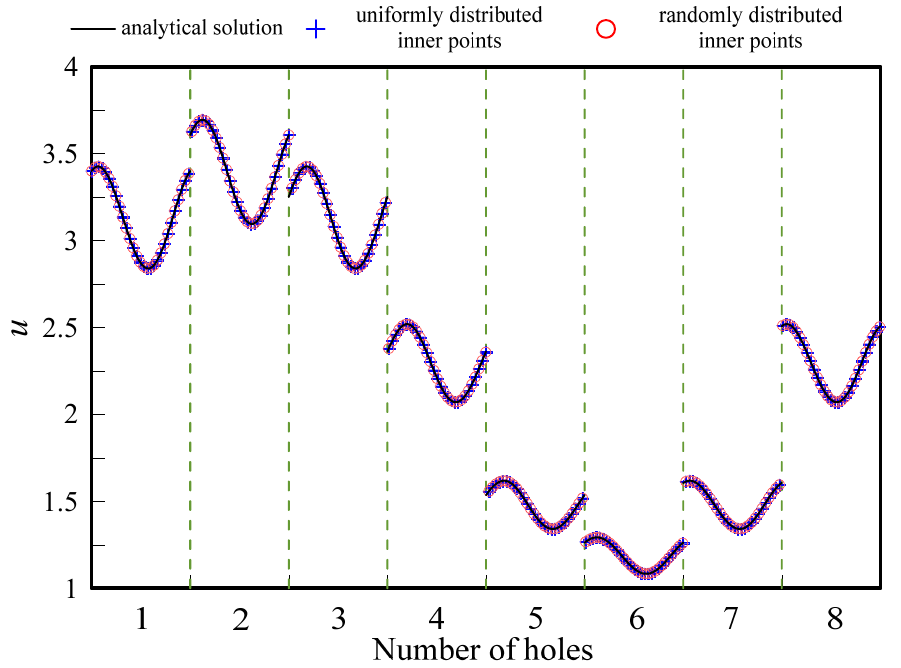
Figure 10. Layouts of the ( a ) uniformly distributed inner points and ( b ) randomly distributed inner points.